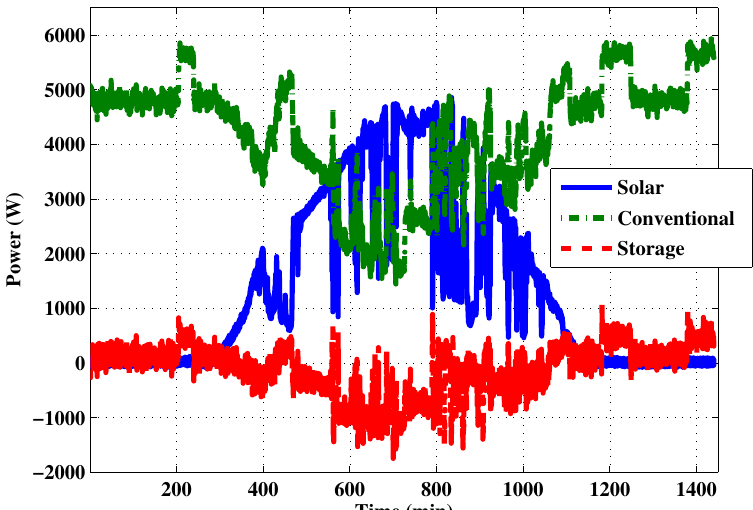
Figure 6. Power supplied by solar, conventional, and storage sources when optimal high dimension droop control is used.